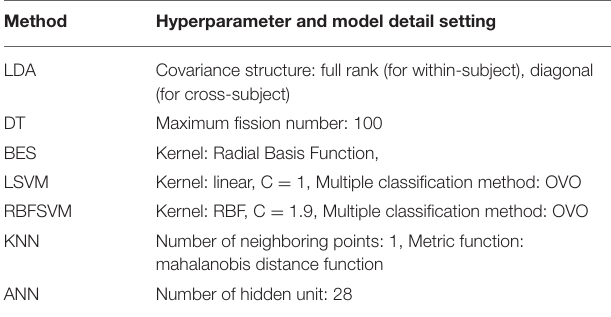
TABLE 1 | Parameter list of traditional MHRI movement prediction approaches. Method Hyperparameter and model detail